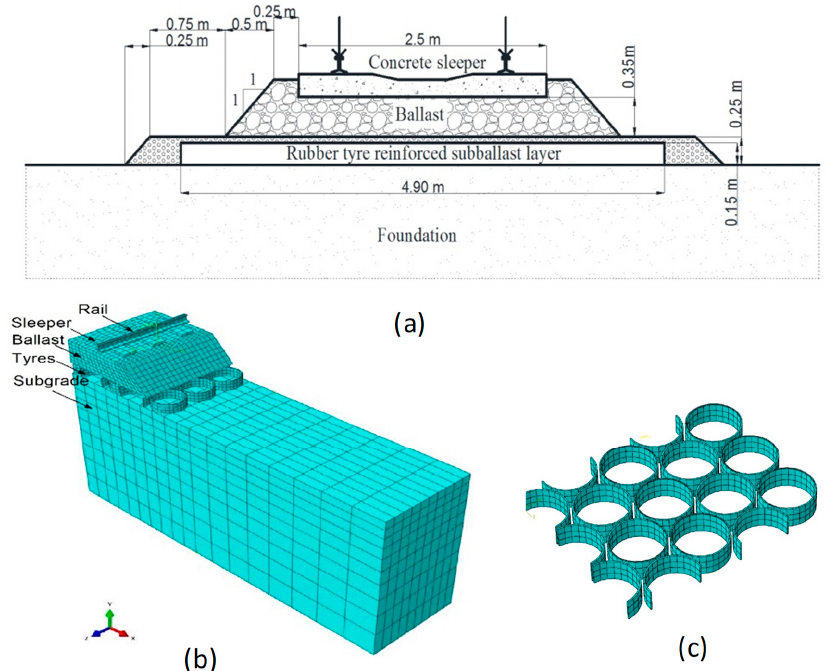
Figure 11. FEM modelling for rubber tire-reinforced capping layer: ( a ) Track geometry with rubber tires reinforced capping layer; ( b ) FEM mesh of ballasted railway track; ( c ) FEM mesh of rubber tires (modified after Indraratna et al. [8]).